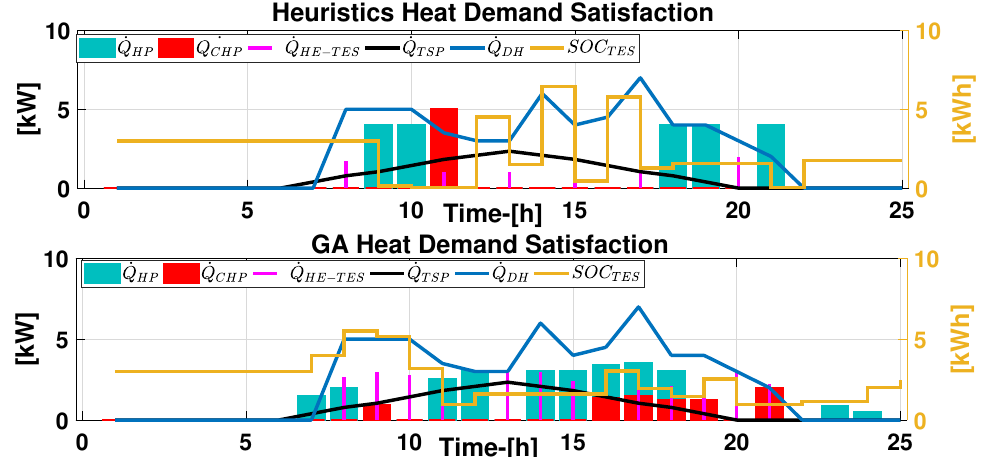
Figure 7. Heuristics and GA heat demand satisfaction numerical results.